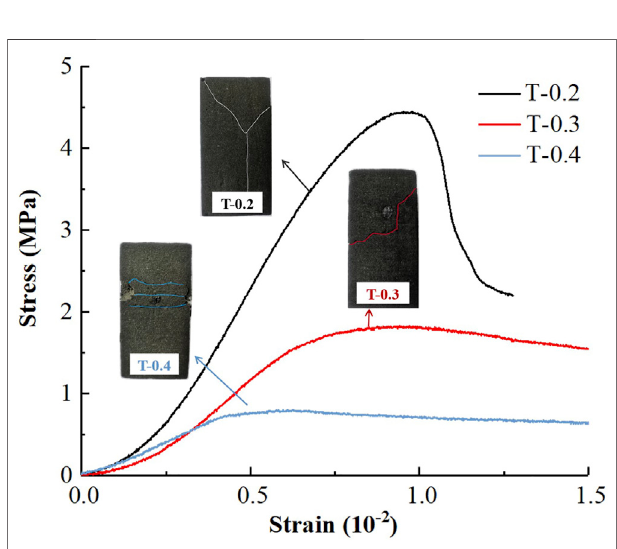
FIGURE 8 | Comparison of specimens with different layer